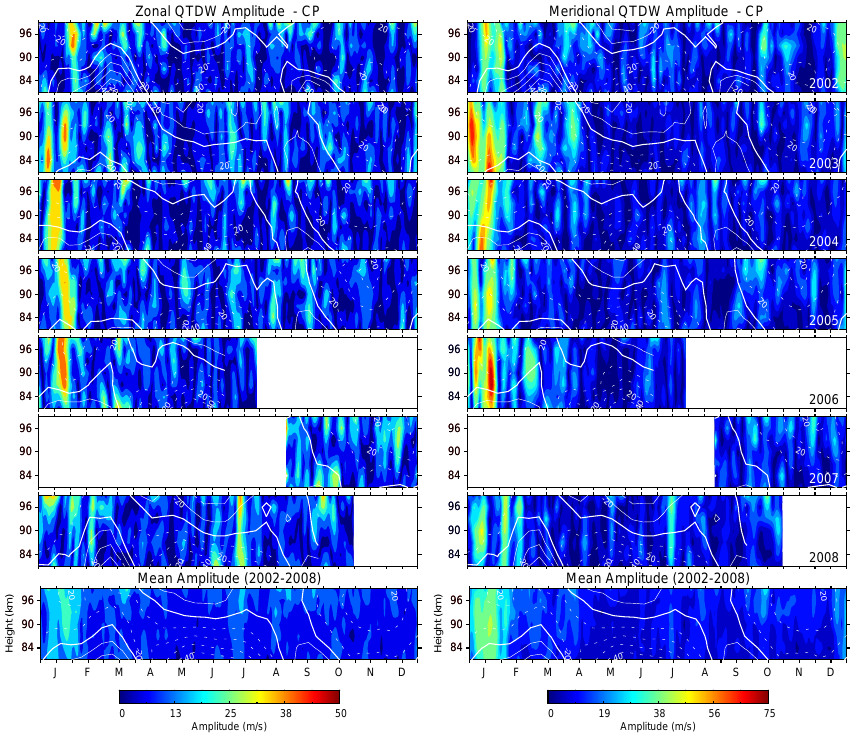
Figure 4. The time-height cross section of the QTDW amplitudes and composite-year QTDW amplitudes over C. Paulista for zonal (left hand plots) and meridional (right hand plots) components, for the years 2002 to 2008. Monthly mean eastward (dotted) and westward (solid) winds also are plotted as open white contours.